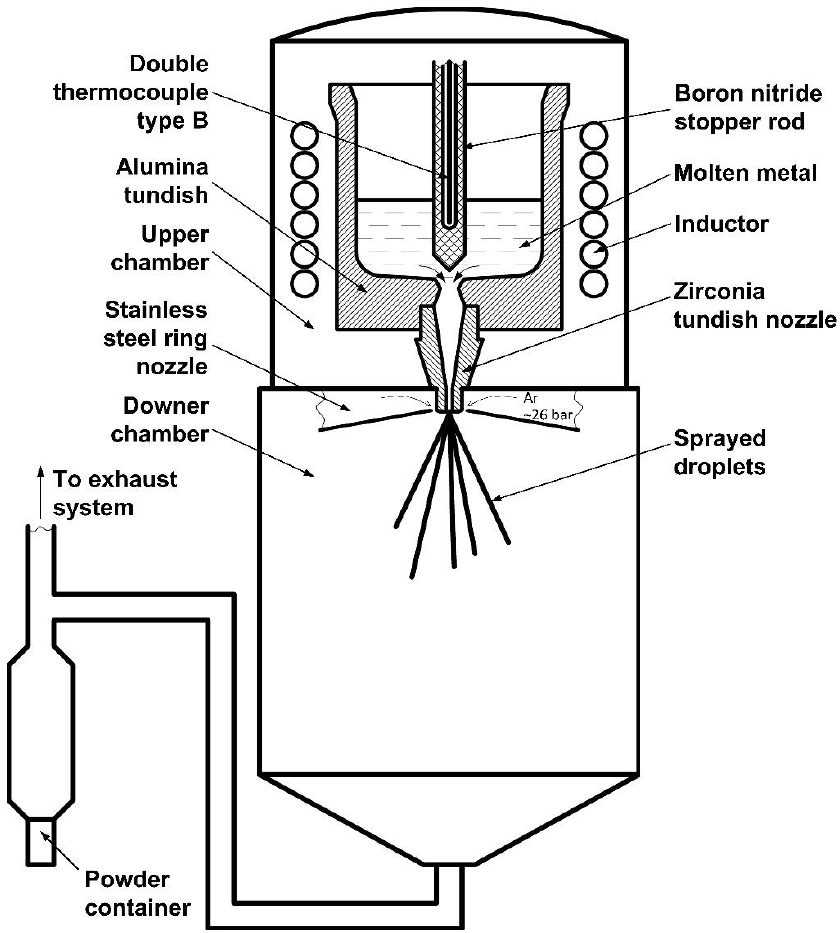
Figure 2. Scheme of inert gas atomization unit VIGA-1B [16] utilized in present